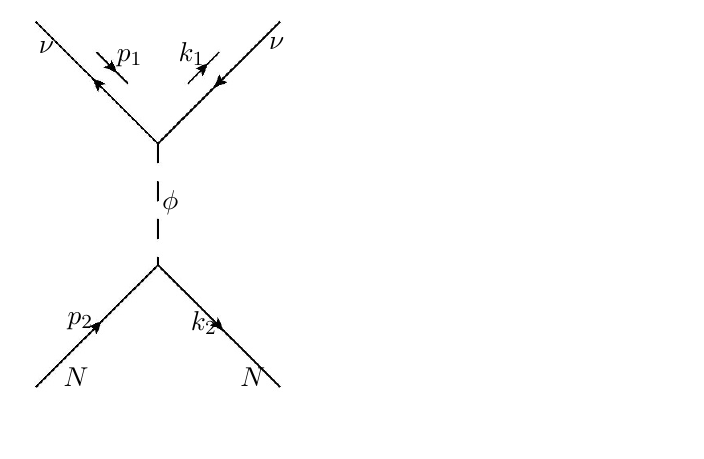
Figure 7 . The Feynman diagram of coherent (cid:23)N scattering mediated by the new light scalar